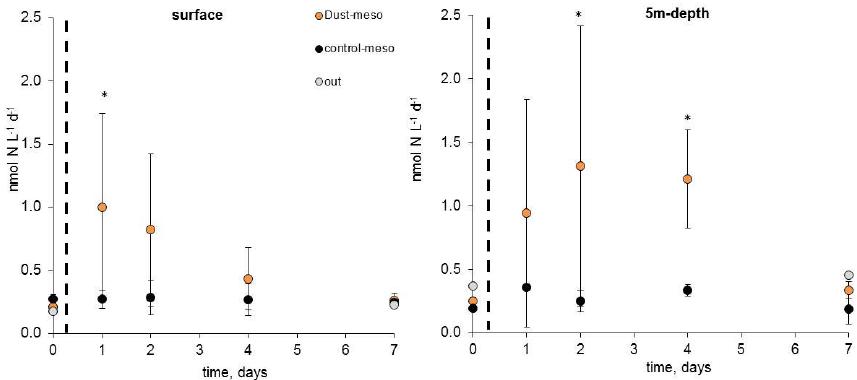
Fig. 1. Mean N 2 fixation rate ( n = 3) in nmolNL − 1 d − 1 during the DUNE-1-P experiment in the Control-meso (black dot), Dust-meso (orange dot) and Out (grey dot) at surface and 5m depth. The dotted line represents the time of the dust seeding. Data in the Control- and Dust-meso represent the average and standard deviation of the three replicate mesocosms. Means in the Dust-meso that were significantly different ( p <0.05) from the Control-meso are labeled with the *